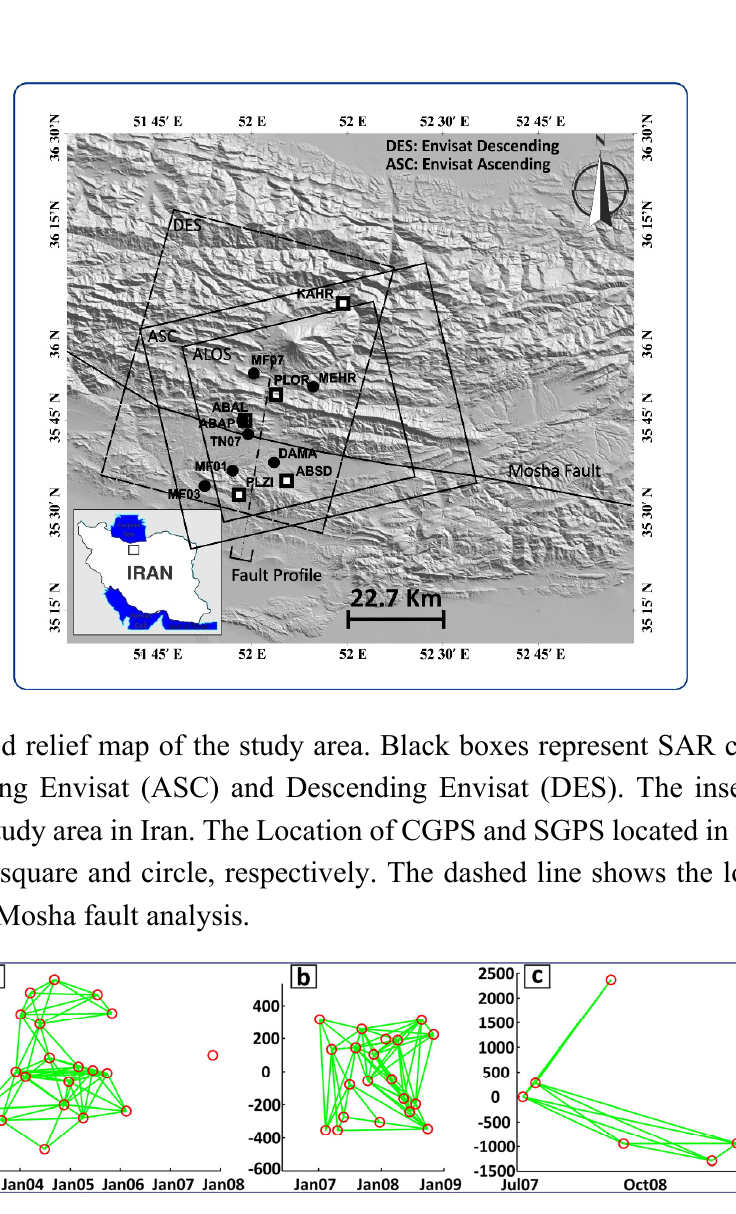
Figure 5. The network of small baseline interferograms for ( a ) Envisat ascending ( b ) Envisat descending and ( c ) ALOS ascending